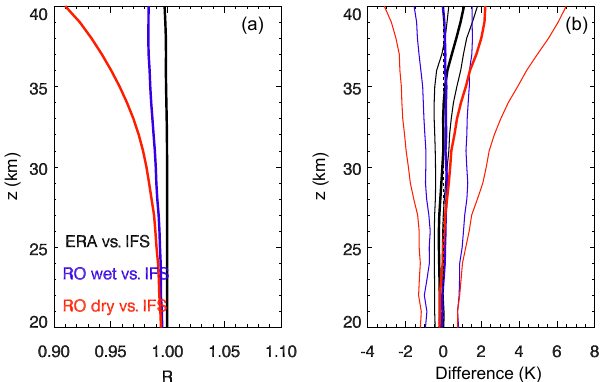
Figure 4. (a) Correlation coefficients as a function of altitude for the correlation between ERA-Interim and IFS data (black line), RO- wet and IFS data (blue line), and RO-dry and IFS data (red line). (b) Corresponding median temperature differences (thick lines) along with 10 and 90% percentiles (thin lines) as a function of alti- tude (same color code as in a